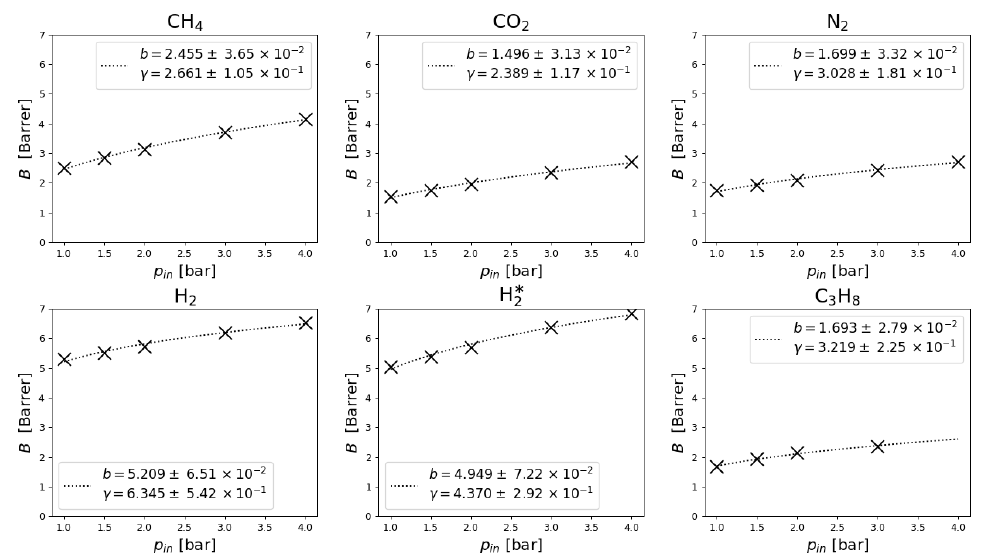
Figure 3. Measurements of gas permeability ( B ) dependence on input pressure ( p in ) and nonlinear power-law regression of measured data. Without the nonlinearity, measurements would be expected to be constant (not only straight line, as the data are normalized).